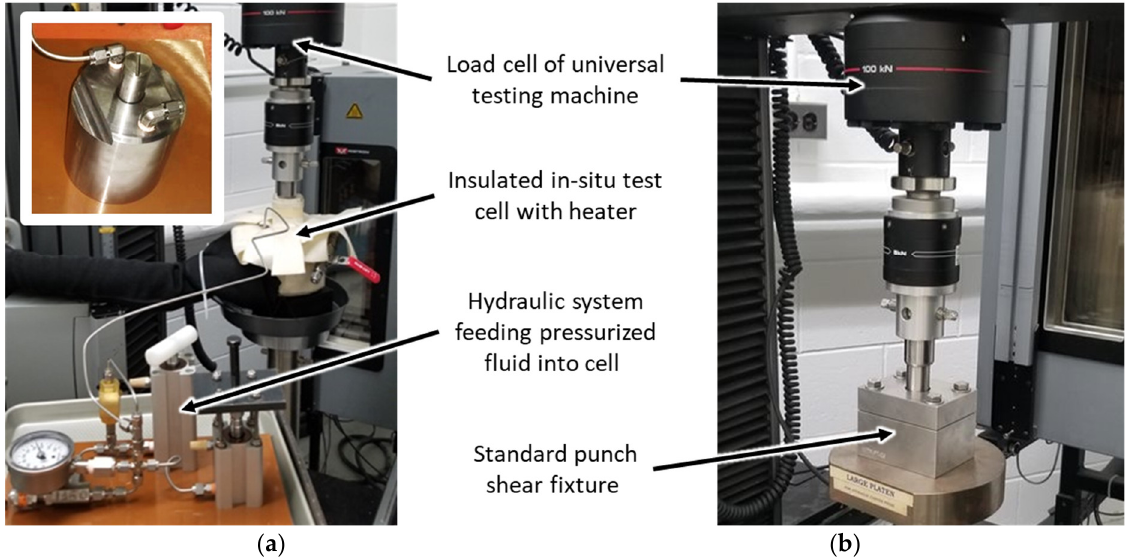
Figure 2. Photographs showing operation of ( a ) in situ test cell (inset: test cell without heater and insulation), and ( b ) standard ASTM D732 fixture.